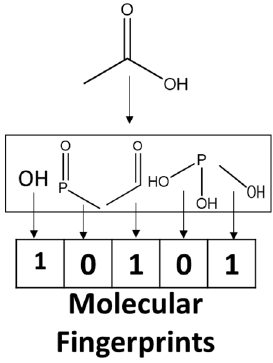
Figure 4. Representation of a binary fingerprint for utilization in